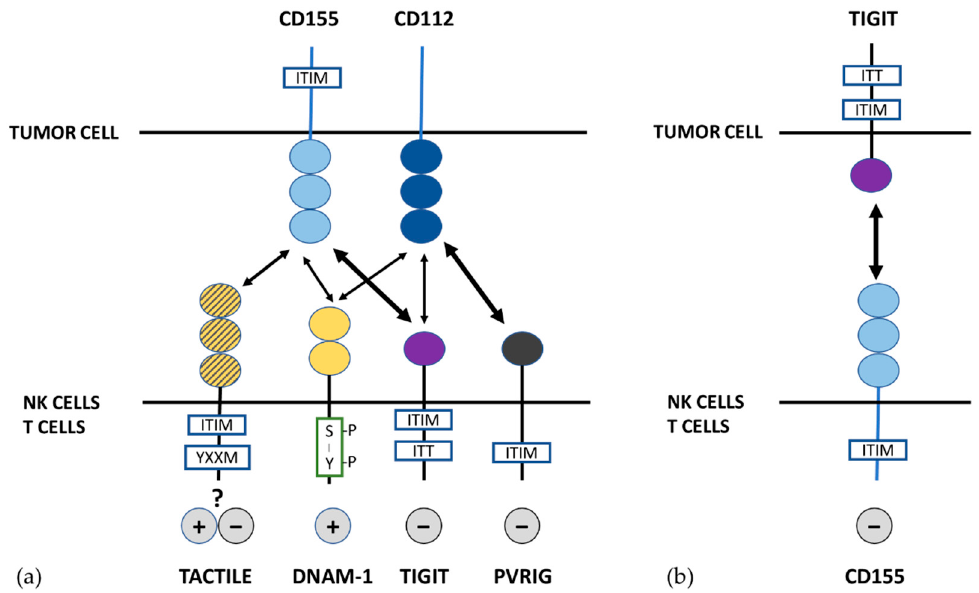
Figure 2. DNAM-1 / TIGIT / PVRIG / TACTILE network and its ligands CD155 and CD112. ( a ) DNAM-1, TACTILE, TIGIT and PVRIG on NK and T cells interact with their ligands on tumor cells with different affinities and mediate activating and inhibitory signaling on cytotoxic cells. ( b ) TIGIT expressed on tumor cells may inhibit NK and T cells by interaction with CD155.